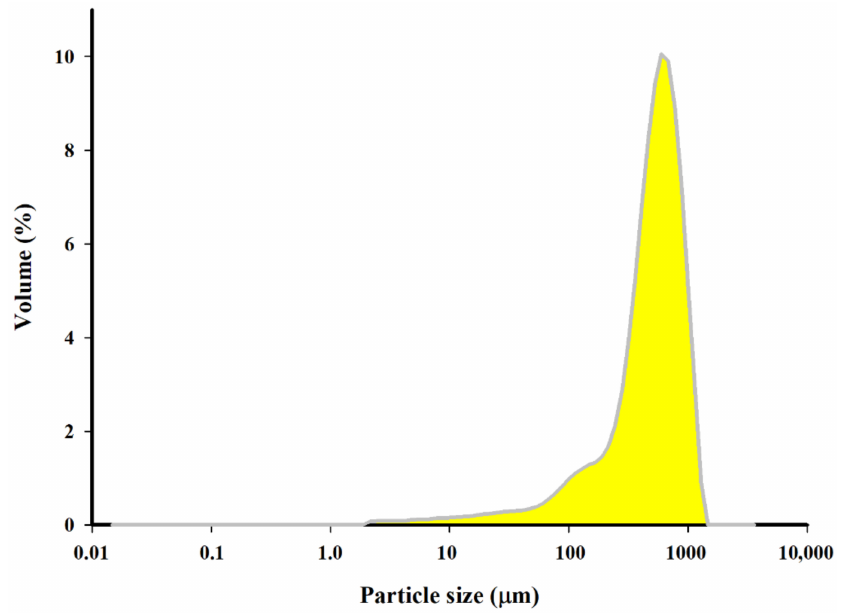
Figure 5. Particle size distribution of the biochar.